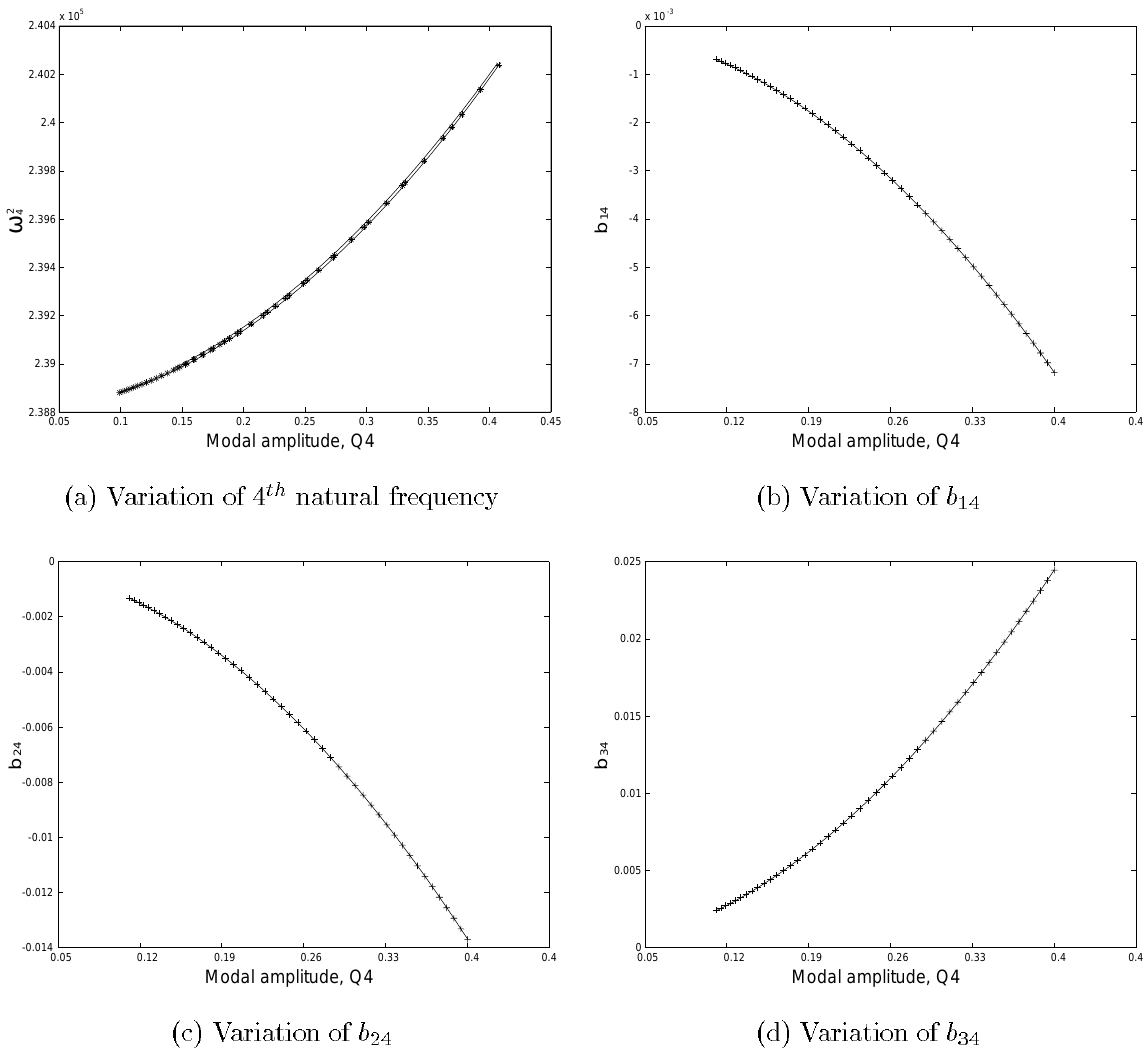
Fig. 3. Non-linear modal parameter variations for the 4-th mode: ∗ ∗ ∗ Extracted values Curve-fitted